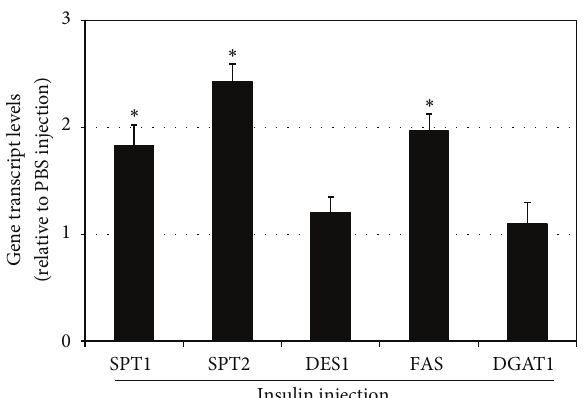
Figure 6: Adult male mice (12weeks) were divided into two groups to receive insulin (INS, 50 nM) or vehicle (PBS) injections every morning for 14d. Soleus levels of genes of multiple enzymes involved with ceramide (SPT1, SPT2, and DES1) and TAG (DGAT1 and FAS) metabolism were quantified. ∗ 𝑃 < 0.05 , INS versus PBS.